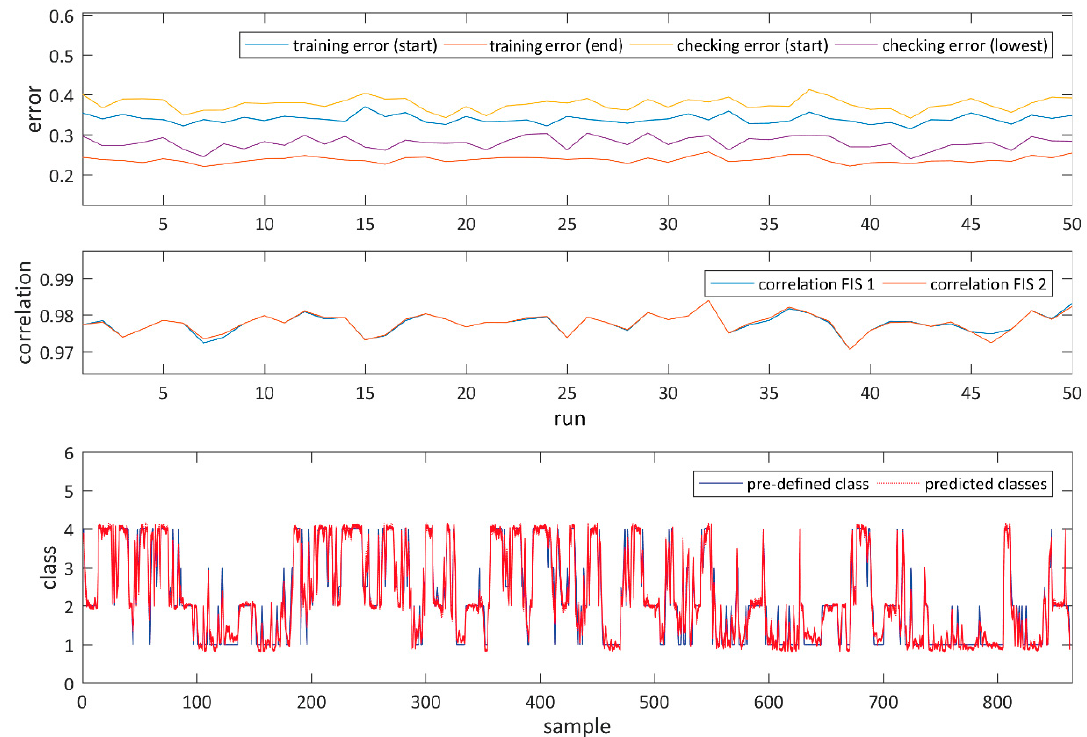
Figure 8. Results and parameters of the fuzzy inference system build from iron and aluminum input data. Top: training and checking errors for 50 consecutive runs; middle: correlation between prediction from the trained systems (FIS 1 is the last FIS from training (after 100 training epochs), FIS 2 is the system with the lowest checking error) and pre-defined classes indicating successful prediction (correlation above 97%); bottom: comparison of predicted and pre-defined classes from FIS